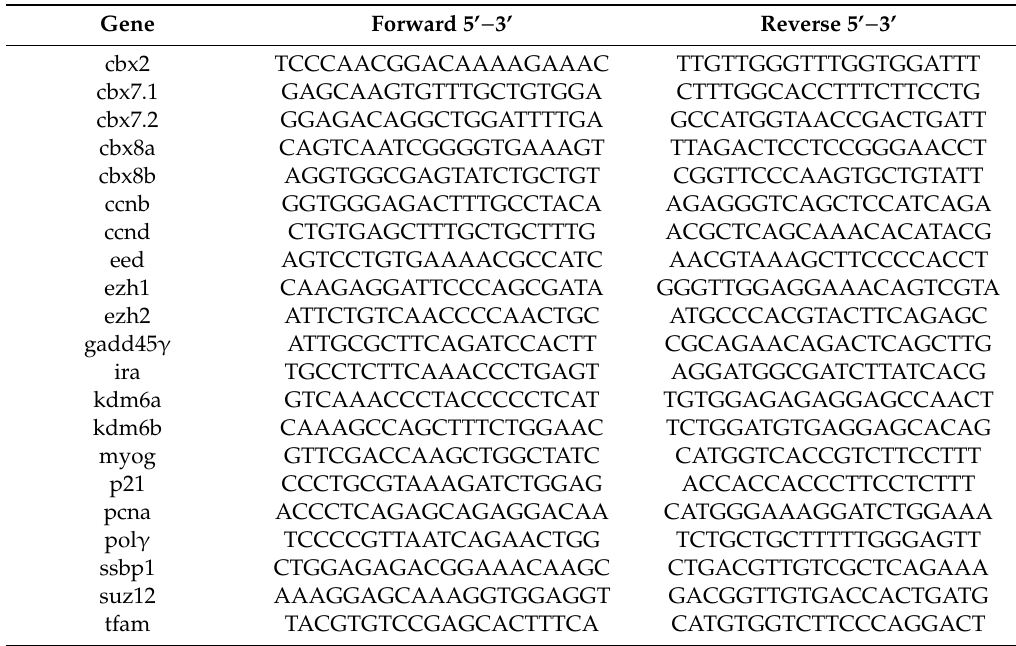
Table 1. List of forward and reverse